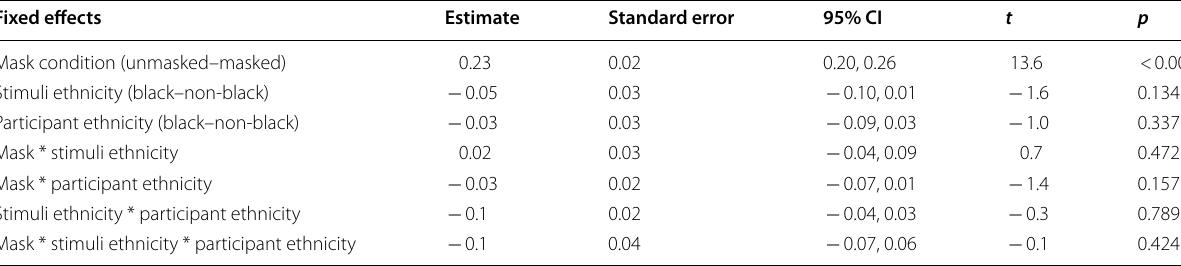
Table 5 Fixed effects table for the black ethnicity linear mixed effects model